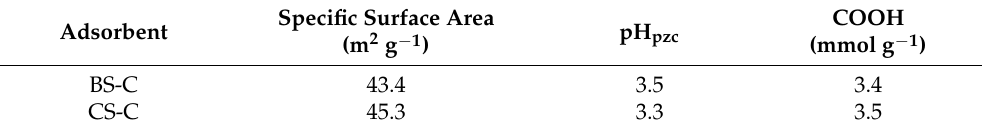
Table 2. Characteristics of BS-C and CS-C. Adsorbent